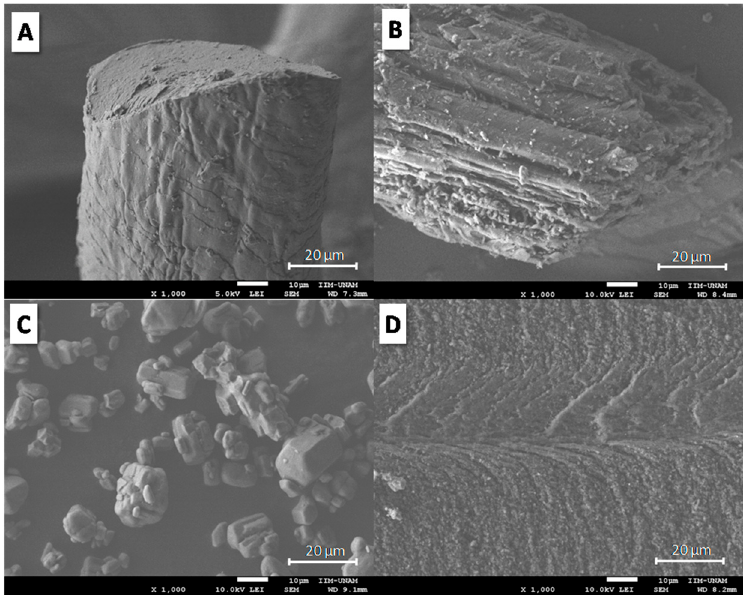
Figure 1. SEM micrographs of ( A ) KF, ( B ) CF, ( C ) APP and ( D ) TPS.